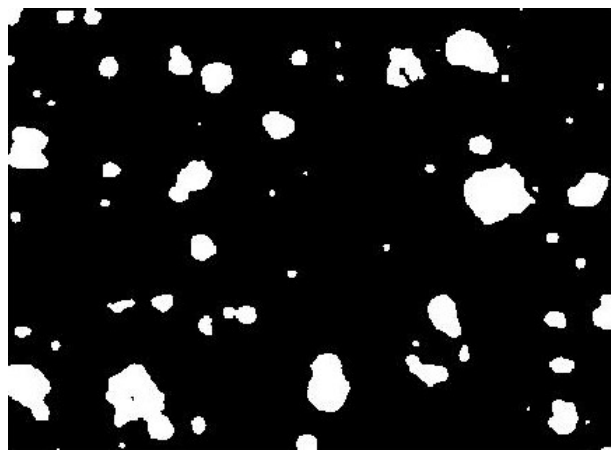
Figure 1. Thermal camera imagery from the DEID, showing re- gions of high-emissivity water (white) on a low-emissivity alu- minum plate